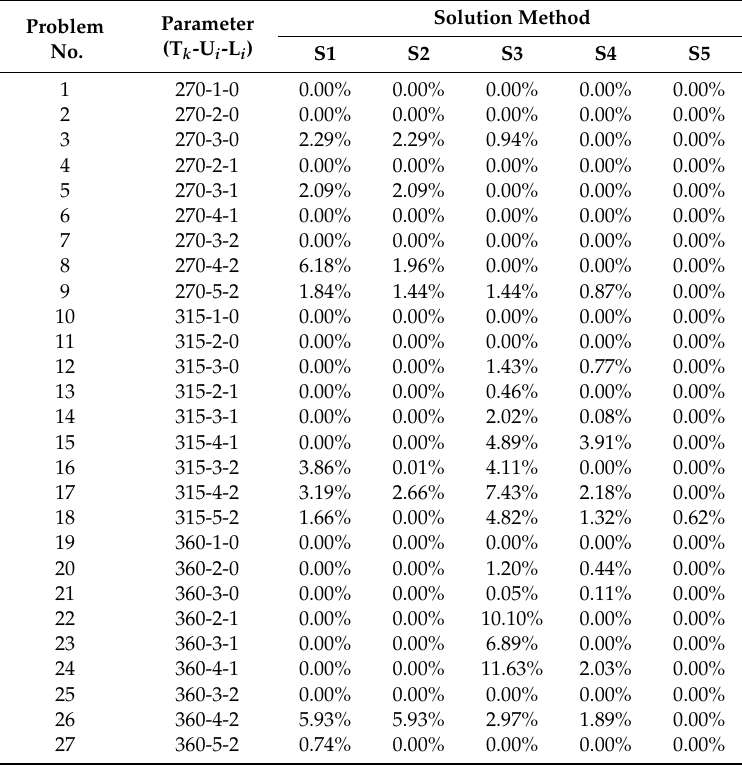
Table 4. Performance gap of the five solution methods under (M, N) = (2, 6). Problem